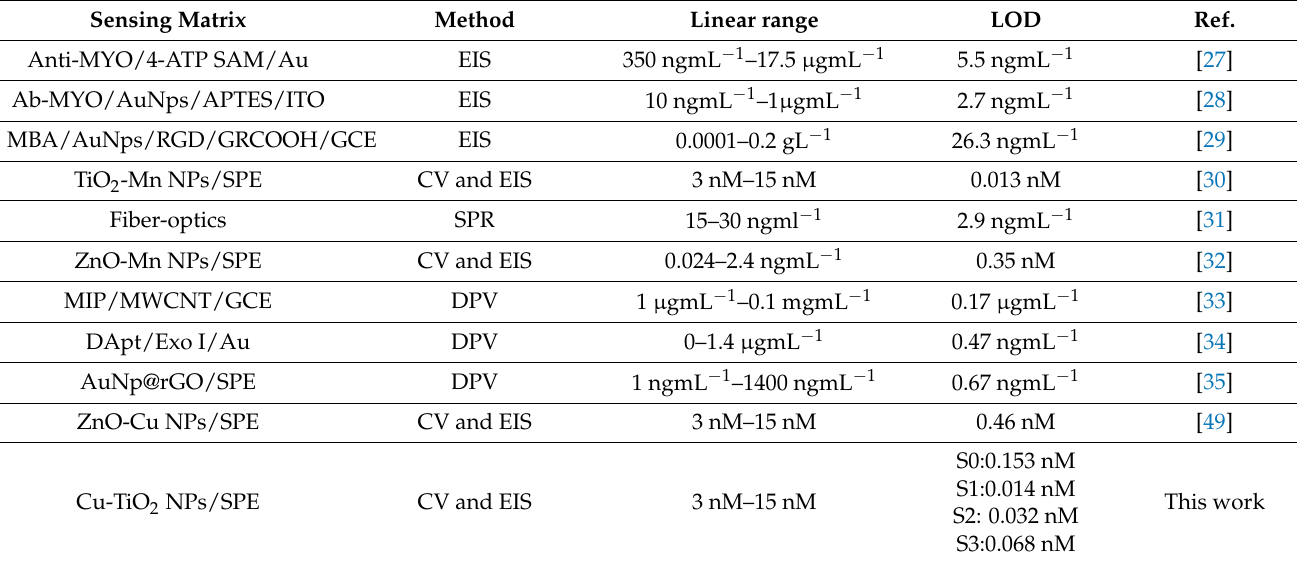
Table 2. Comparison of the sensing performance of fabricated Mb sensors with other reported Mb sensors fabricated based on various sensing